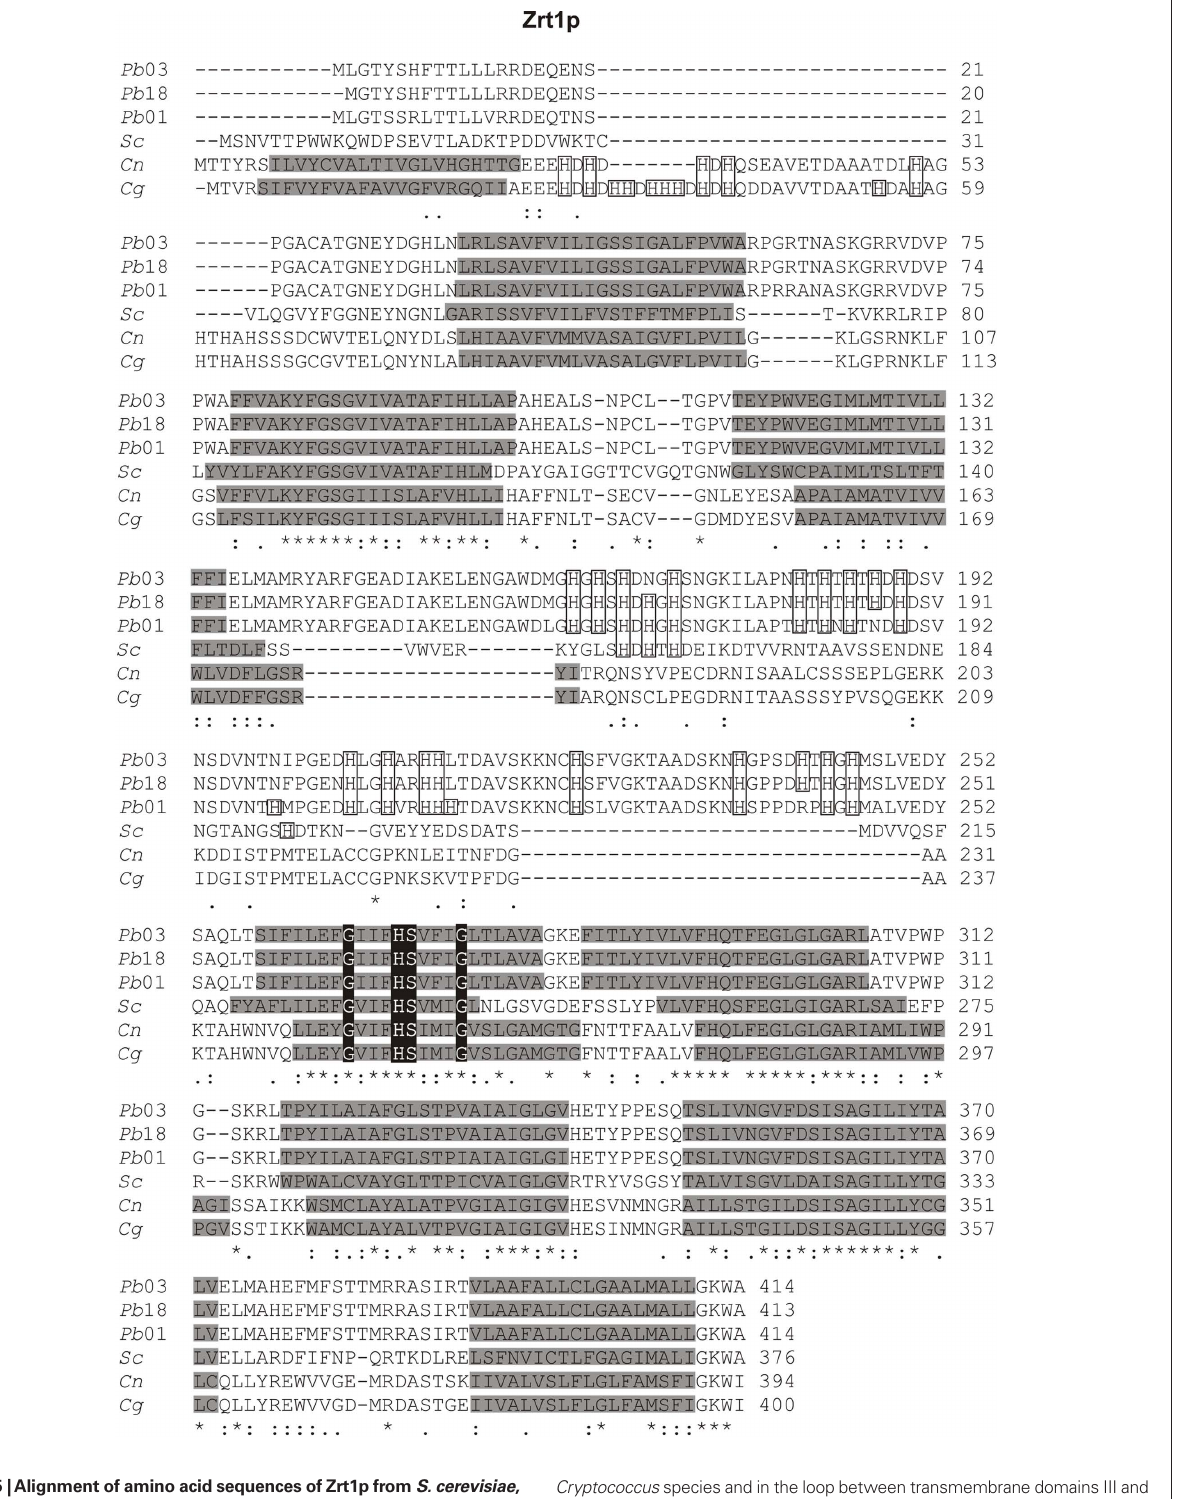
Cryptococcus species and in the loop between transmembrane domains III and IV in P. brasiliensis and S. cerevisiae are boxed. Asterisks indicate amino acid identity and dots represent conserved substitutions. Accession numbers: Pb 03 (PABG_07725.1), Pb 18 (PADG_08567.1), Pb 01 (PAAG_08727.1), Sc (NP_011259), Cn (CNAG_03398.2) and Cg